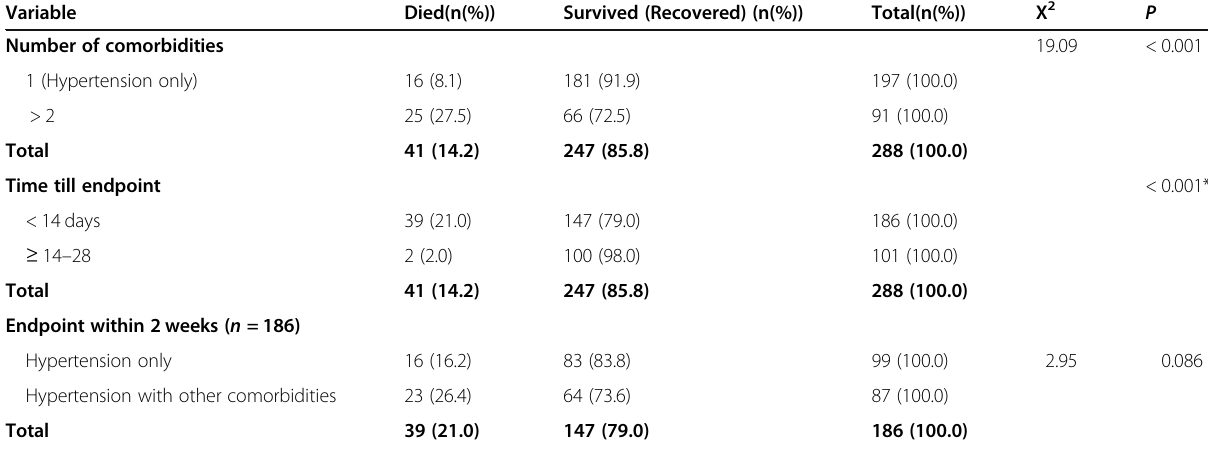
Table 3 Mortality among COVID-19 hypertensive patients (with or without other comorbidities, < or > 2 week of admission) Variable